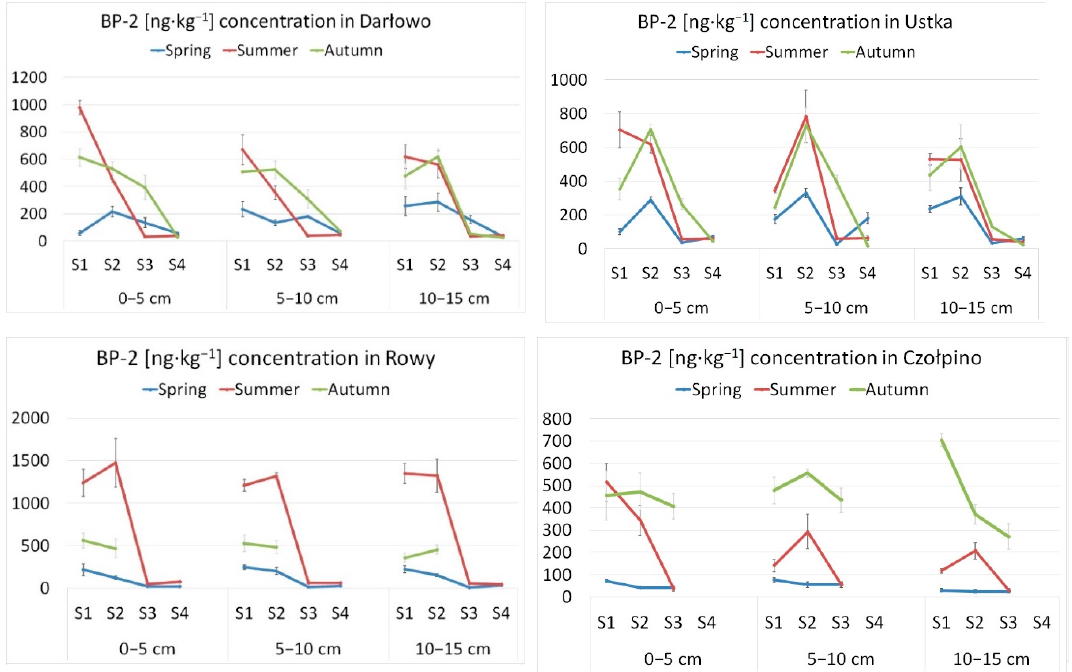
Figure 3. BP-2 [ng·kg − 1 d.w.] concentration in sand sediments collected in Dar ł owo, Ustka, Rowy, and Figure 3. BP-2 [ng · kg − 1 d.w.] concentration in sand sediments collected in Darłowo, Ustka, Rowy, and Czo ł pino according to seasonality and distance from the waterline. Czołpino according to seasonality and distance from the waterline. Water 2020 , 12 , x FOR PEER REVIEW 9 of 16